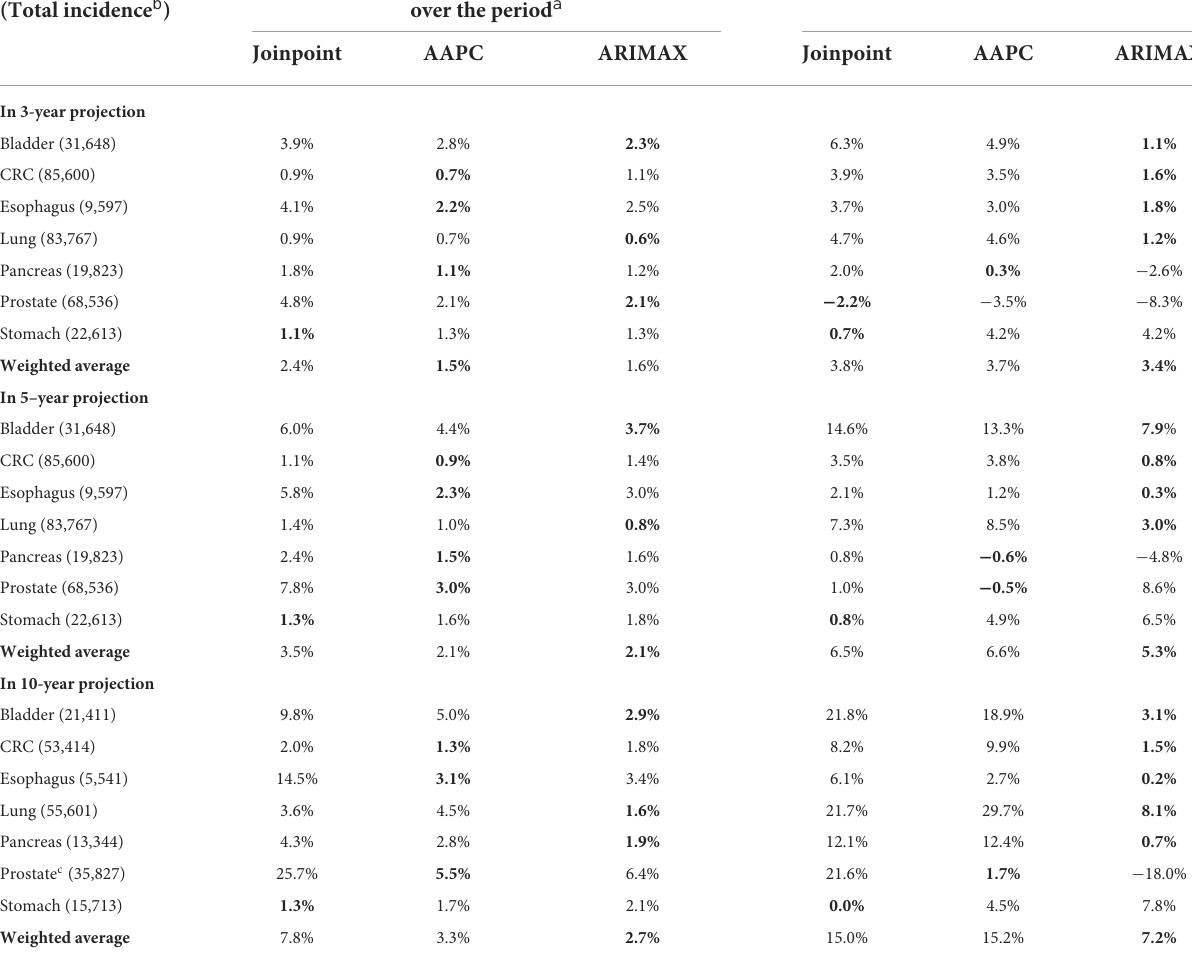
TABLE 2 Comparison between actual and projected cancer